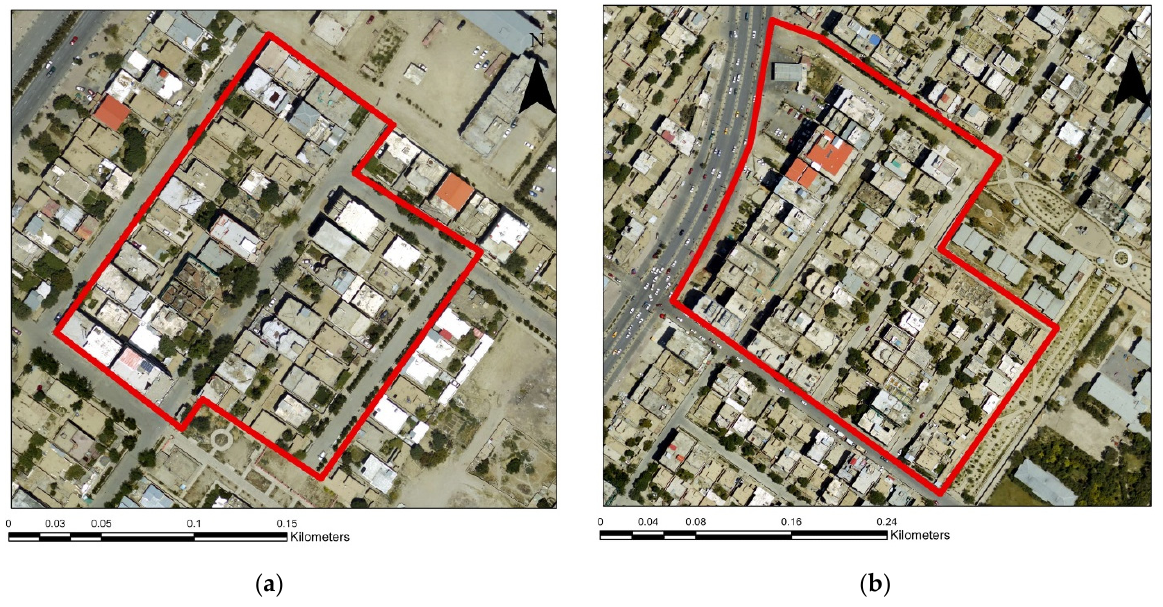
Figure 2. Aerial photos of study areas; ( a ) Parwan-2: a study area located in southern part of district 4; ( b ) Taimani: a study area located in northern part of district 4.